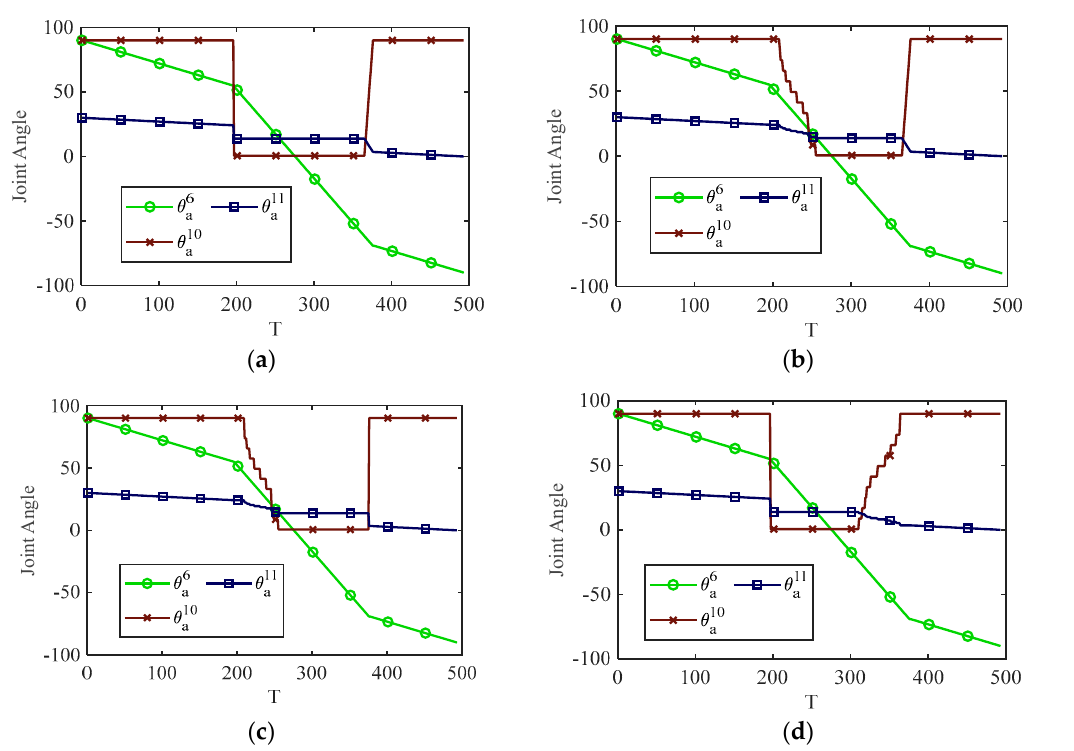
Figure 30. Paths of all motion joints of the SMSRS under four collision-free paths: ( a ) path 1, ( b ) path 2, ( c ) path 3 and ( d ) path 4.